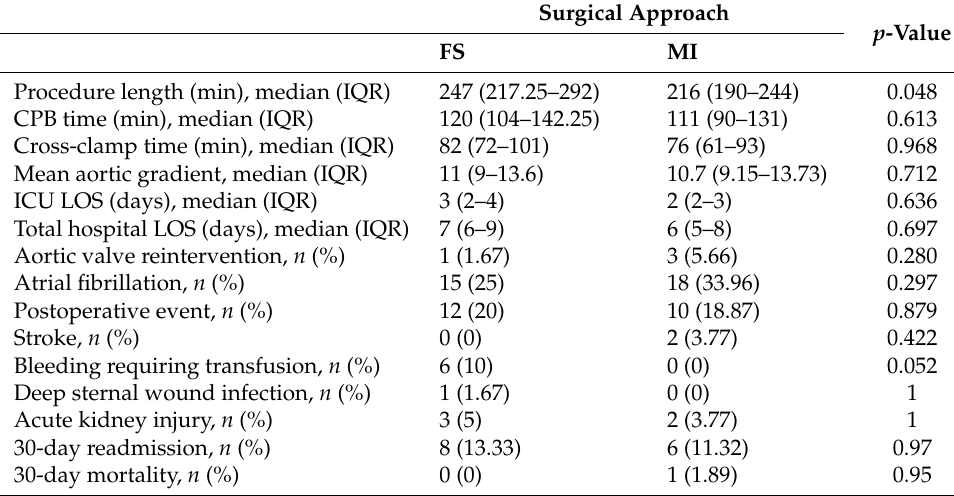
Table 2. Perioperative parameters and postoperative